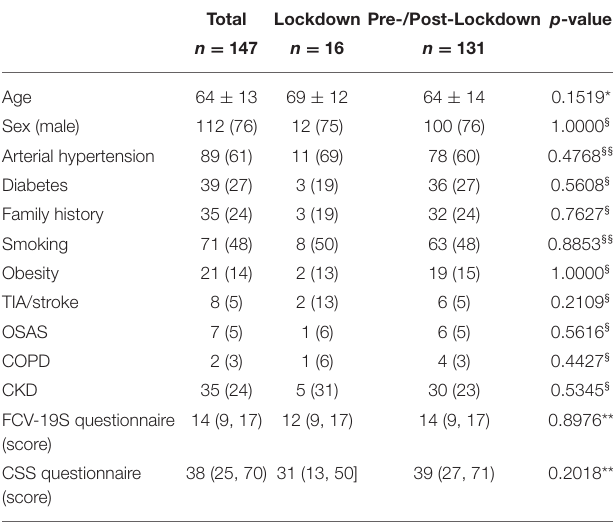
TABLE 1 | Patient characteristics at